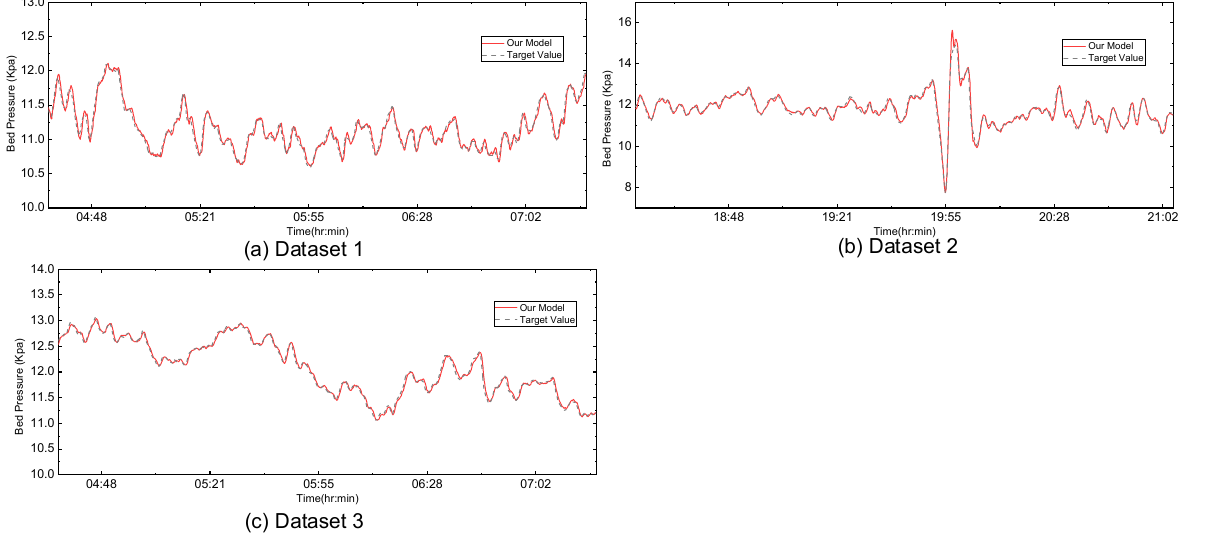
Figure 10. The prediction results diagram of bed pressure. Table 5. Prediction results table.